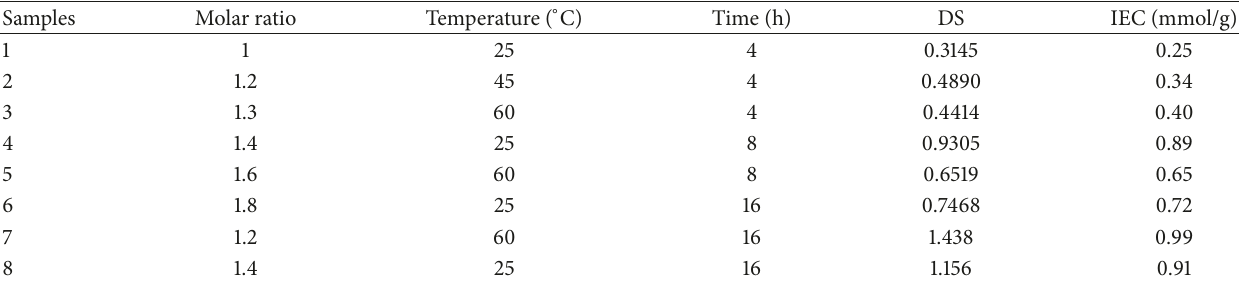
Table 1: Influence of the reaction conditions on the degree of substitute (DS) of the product.